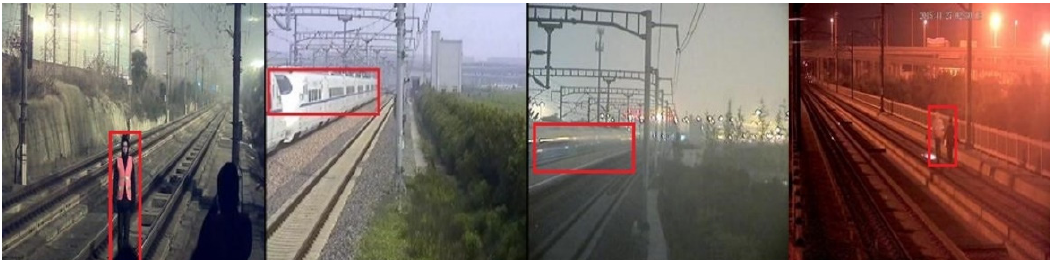
Figure 9. Samples of the railway dataset.